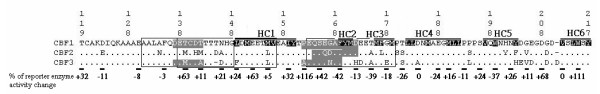
Sites of predicted positive selection in the transcriptional activation domains of CBF1, -2, and -3. The figures were modified according to Figure 3B of Wang et al. [50]. Ninety-eight amino acids of the CBF1 C-terminal were aligned with the same domains of CBF2 and -3 (Col ecotype). The numbers above the upper panel are amino acid numbers of the protein sequence alignment. Six hydrophobic clusters are labeled by a line above each cluster, and hydrophobic residues within clusters are indicated by black blocks. Reporter constructs possessing an alanine-substituted CBF1 activation domain were used to estimate the contribution of motifs or residues to transactivation activity. The alanine-substituted residues are indicated by black underlining below each site, and the percentages of changes in reporter enzyme (β-galactosidase) activity related to the wild-type CBF1 activation domain construct are indicated just below each underlined alanine substitution. Sequences boxed by rectangles indicate regions which had the highest Ka/Ks ratios in the transcriptional activation domains in Figure 4A. Gray blocks covering amino acid sequences indicate regions in which the Ka/Ks ratios exceed 1 using a non-overlapping sliding window method (i.e., the gray block covering residue sites 137 to 142 representing this region of six residues was detected in the comparison of CBF1 and -3). There are three pair-wise comparisons between CBF1, -2, and -3, and four regions were labeled by gray blocks.